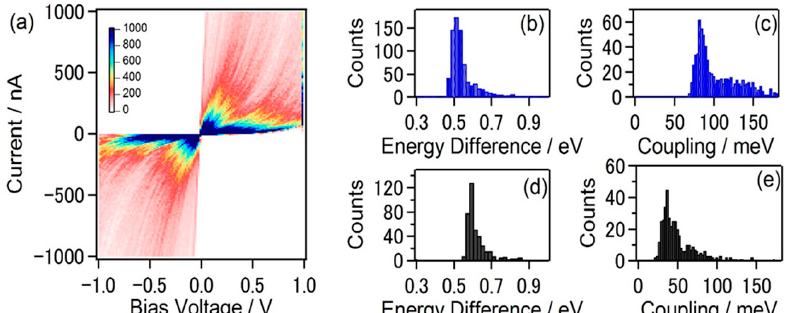
Figure 10. ( a ) 2D histogram of the I – V curves of C 60 single molecule junction; The distribution of ( b , d )